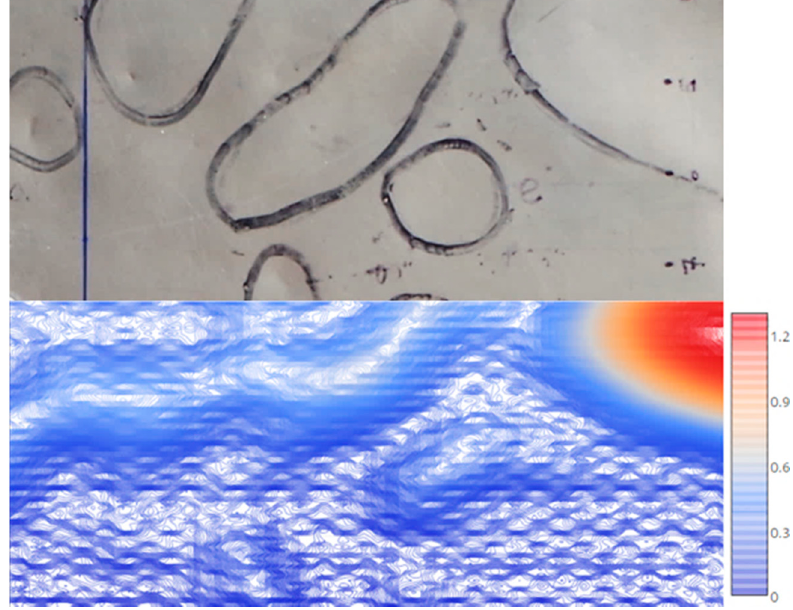
Figure 11. ECT core evaluation; panel surface ( top ) and ECT results plotted at 0.0015 mm contour step size ( bottom ) (25 kHz).